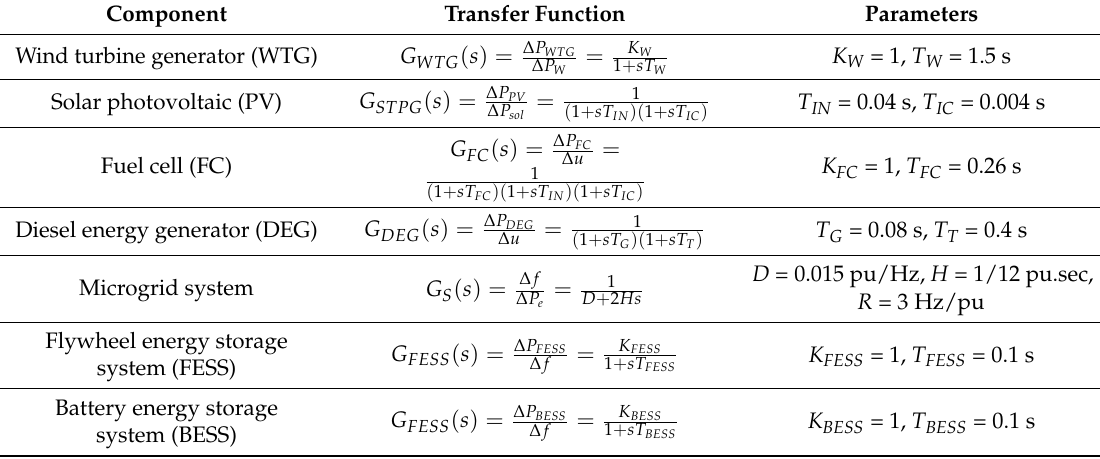
Table 1. The small-signal analysis models and parameters of the components of an islanded microgrid [25].